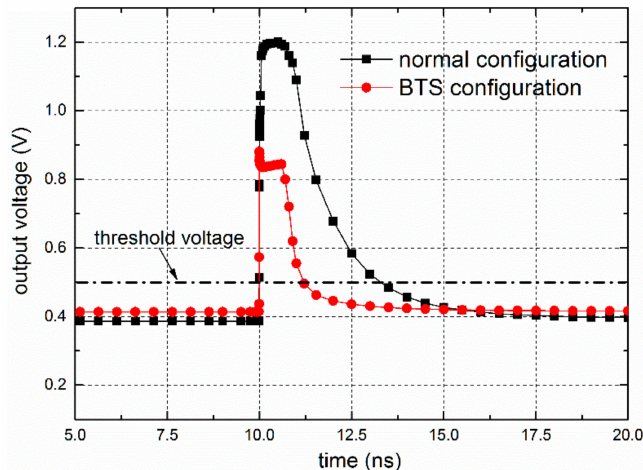
Figure 4. Transient voltages at di ff erent well bias